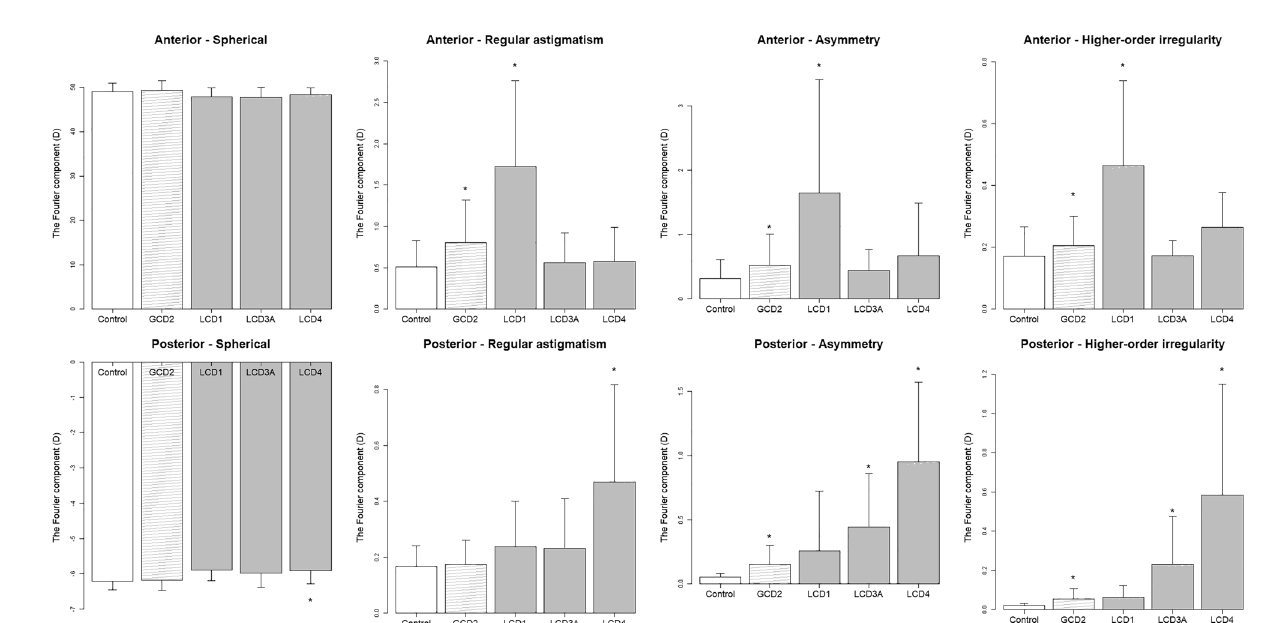
Figure 3. Fourier components for comparison between the subtypes and controls. * indicates statistically significant difference. GCD2 = granular corneal dystrophy type 2, LCD1 = lattice corneal dystrophy type 1, LCD3A = lattice corneal dystrophy type IIIA, LCD4 = lattice corneal dystrophy type